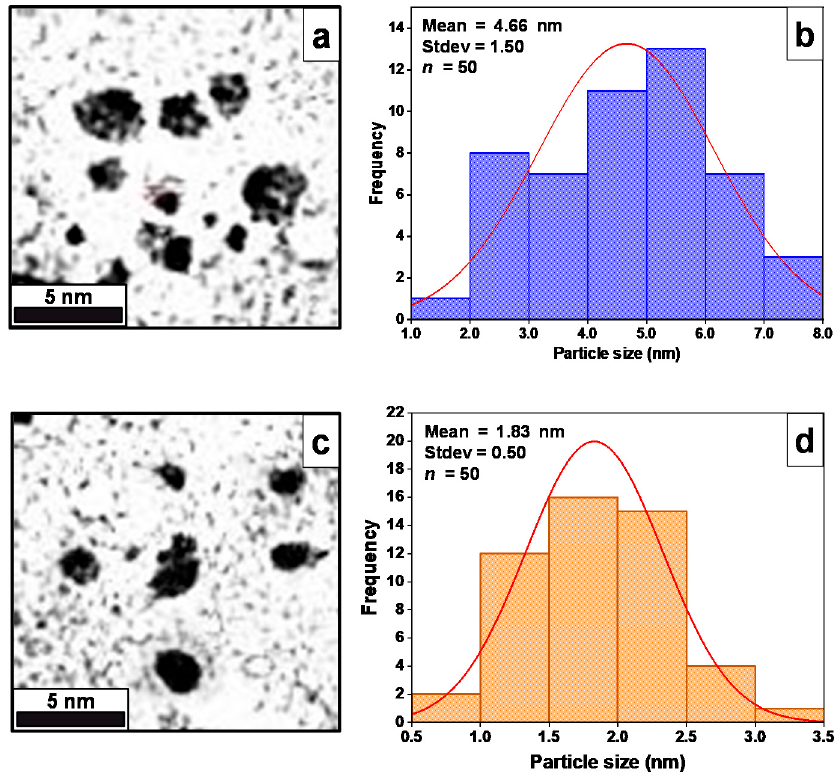
Figure 3. HRTEM images of ( a ) ZnS and ( c ) Mn:ZnS QDs; corresponding particle size distributions for ( b ) ZnS and ( d )